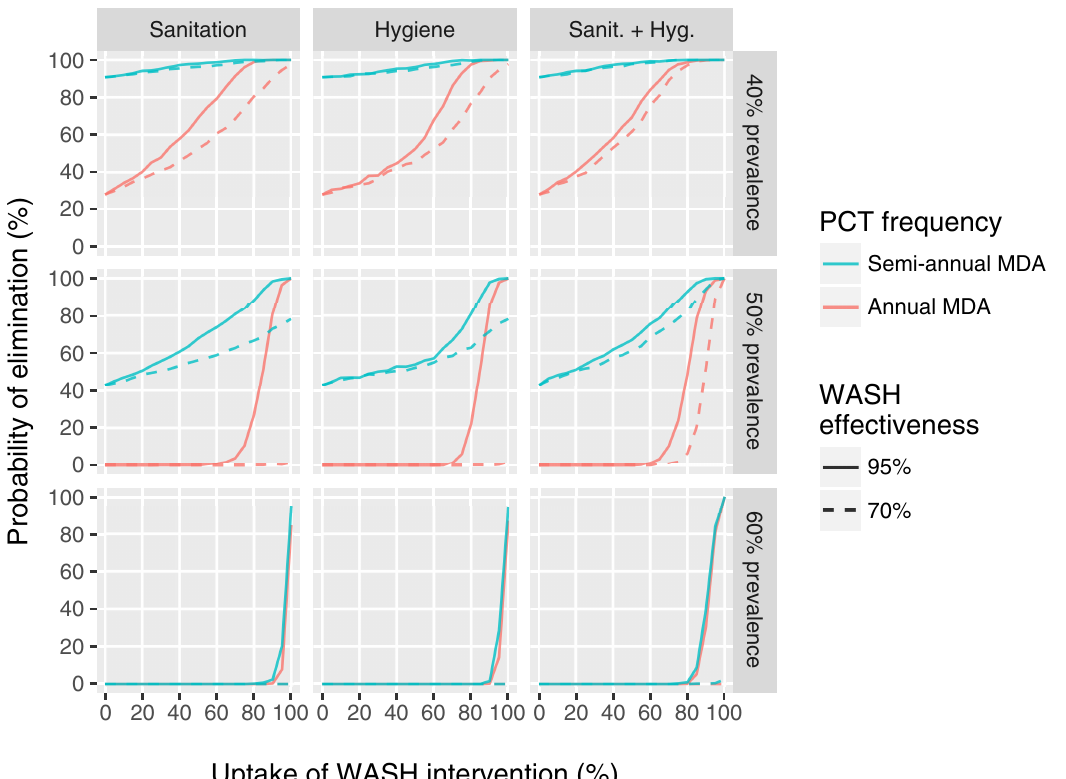
Fig 4. Effect of uptake and effectiveness of different WASH modalities on the probability of elimination of hookworm infection after five years of community-wide PCT. Rows of panels represent settings with different pre-control hookworm infection prevalence in the general population. For all three settings, we simulated five years of either annual (red lines) or semi-annual (green lines) community-wide PCT with ALB, implemented at 90% coverage. After five years, PCT is stopped and one of three types of WASH interventions (columns) is simulated, which reduce participating individuals’ contribution (sanitation) and/or exposure (hygiene) to the environmental reservoir of infection by 70% or 95% (effectiveness), represented by solid and dashed lines, respectively. Uptake of WASH interventions (x-axis) is defined as the (random) proportion of people who take up the intervention. Uptake of sanitation and hygiene measures in the combined WASH intervention (third column) is assumed to be perfectly correlated within individuals. Elimination is defined as absence of any worms 50 years after stopping PCT in the simulated population of about 400 individuals.